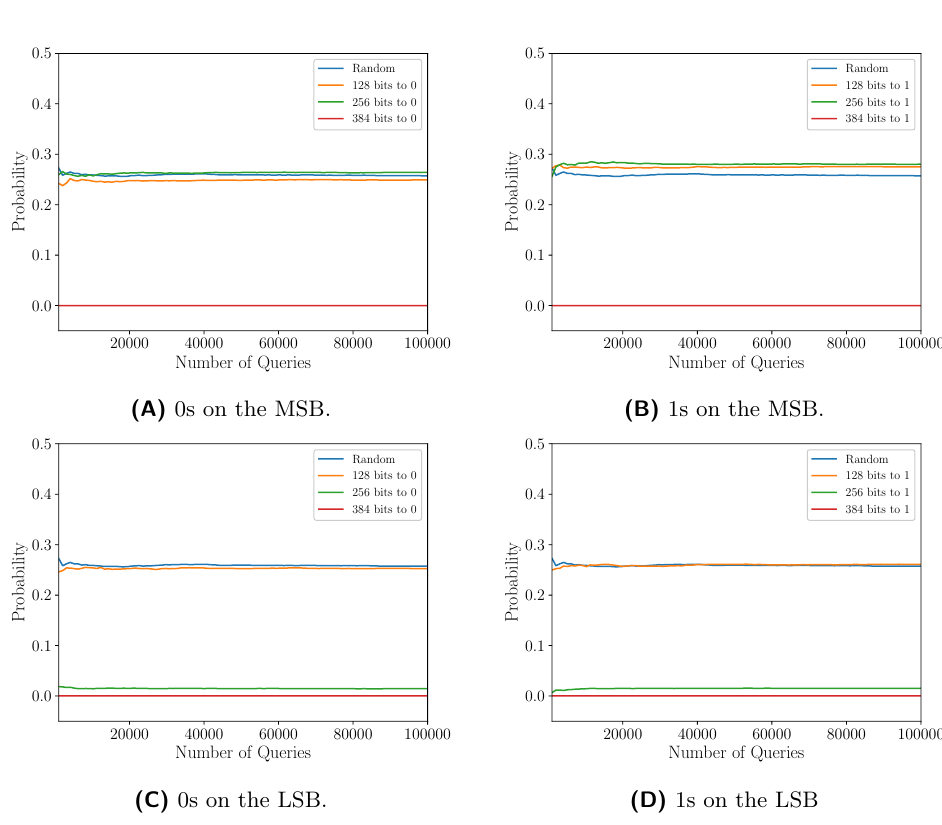
Figure 7: Inputs’ filtering attack on the proposed LPPN